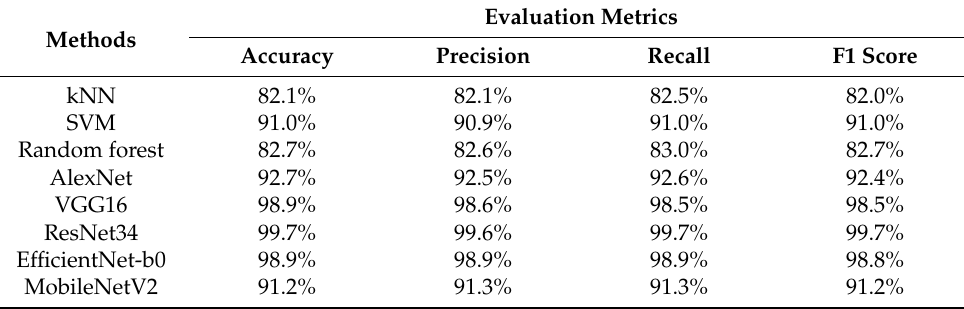
Table 3. Results for the tested ML/DL